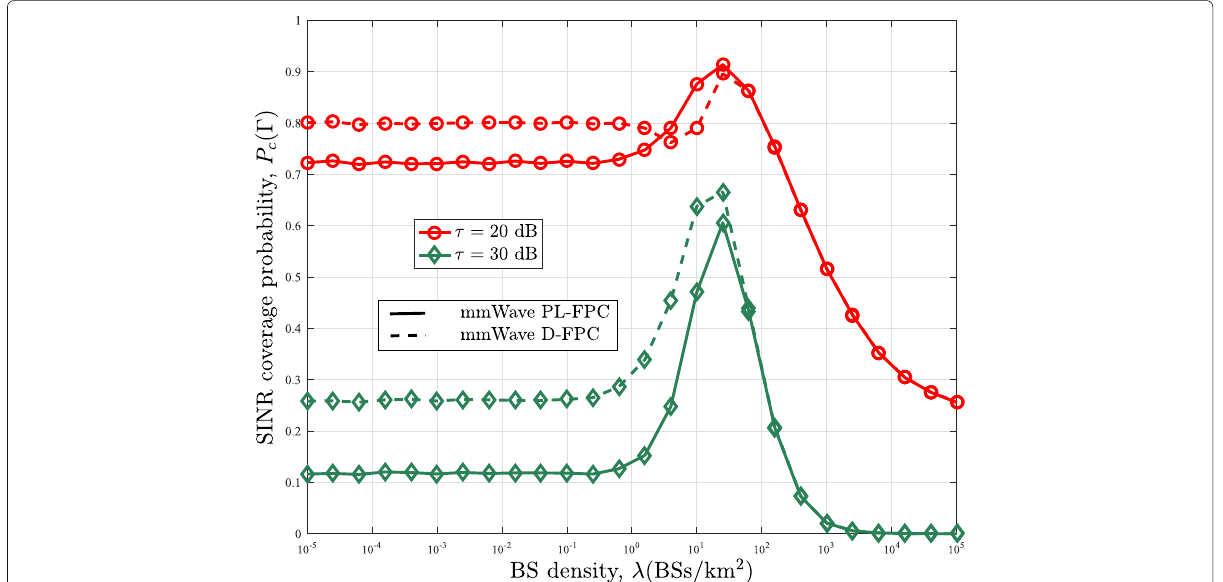
Fig. 10 SINR coverage probability with the power control factor τ = 1 and propagation environment with α L = 2.5 and α N =